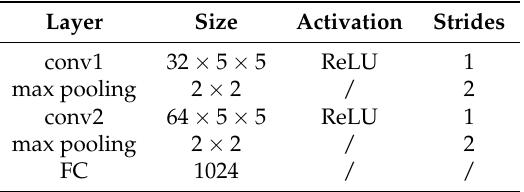
Table 1. Network settings in the spatial attention